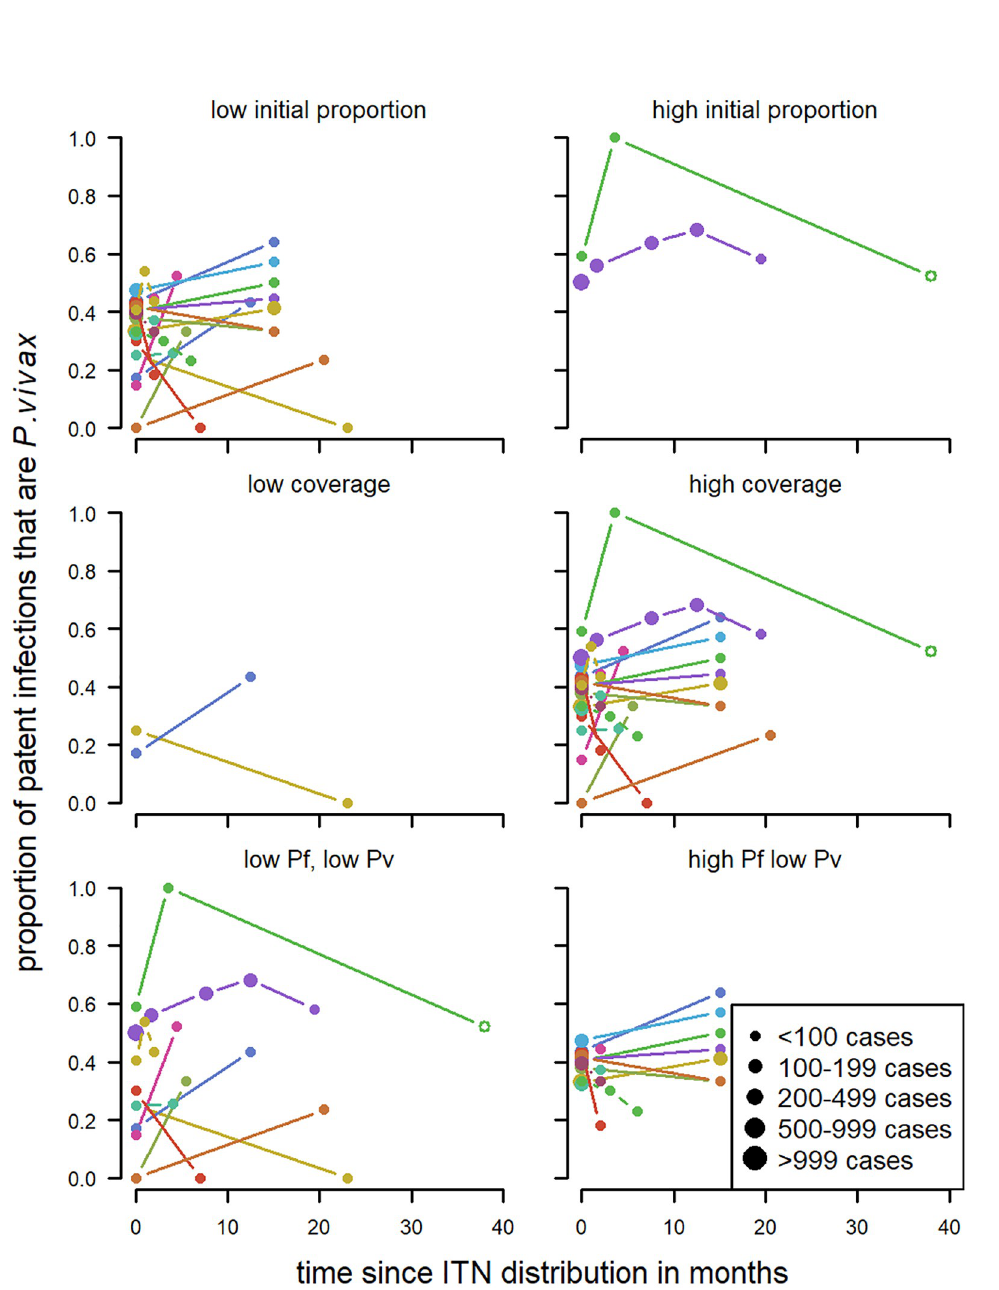
Fig 13. Spaghetti plots splitting the series of time-points of the proportion of patent infections that are P. vivax by initial proportion of P. vivax , coverage and transmission intensity after repeated distribution of ITNs. Excluding series of time points that have no measurement within 24 months after the intervention. Dot size depending on number of infections.